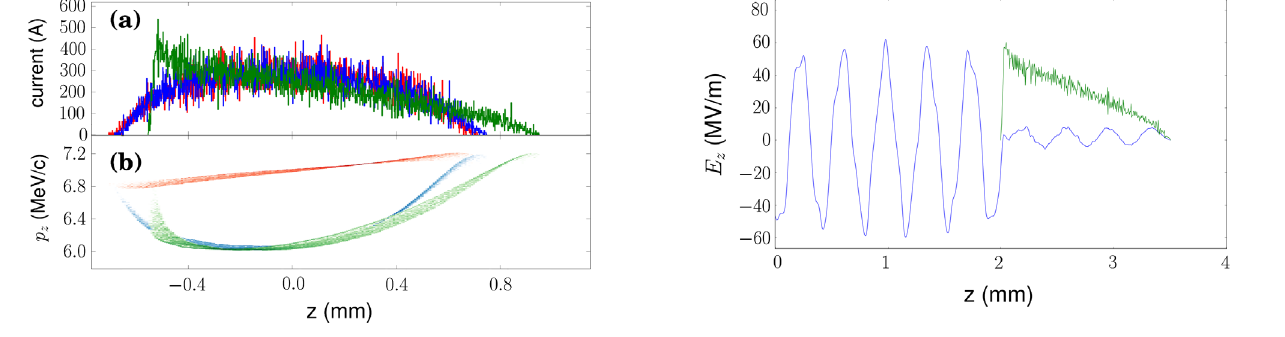
FIG. 12. Current profiles (a) and longitudinal phase spaces (b) at the entrance (red traces) and exit (red traces) of the DLW structure and 0.2 m downstream of the structure ( s ≃ 0 . 54 m from the photocathode surface) where a quasilinear current profile is achieved (green traces).